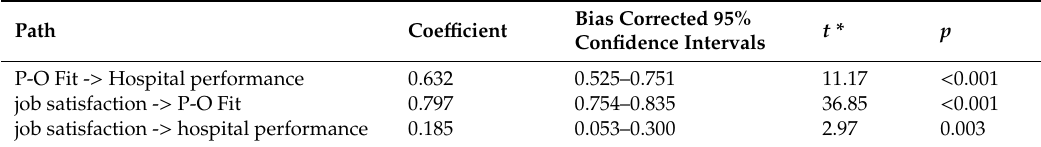
Figure A3. Mediating e ff ect of P-O fit (Person-Organization fit) on the relationship between job satisfaction and hospital performance (Two items deleted from job satisfaction scale). Table A3. Structural model assessment (PLS path model with mediator).